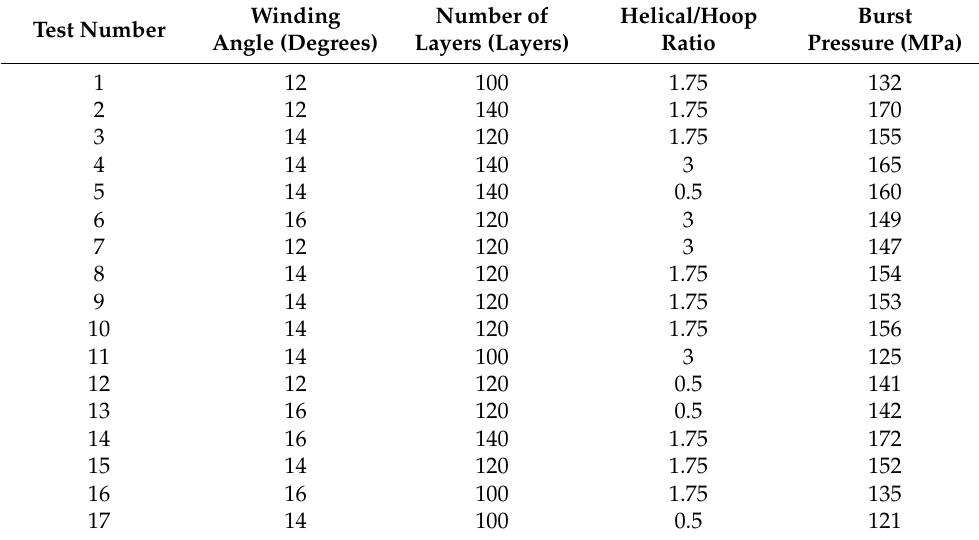
Table 5. Box-Behnken design